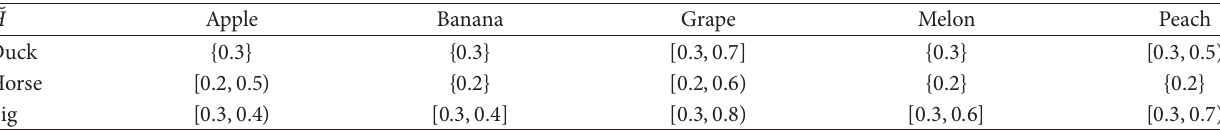
Table 6: Tabular representation of the hesitant fuzzy soft set